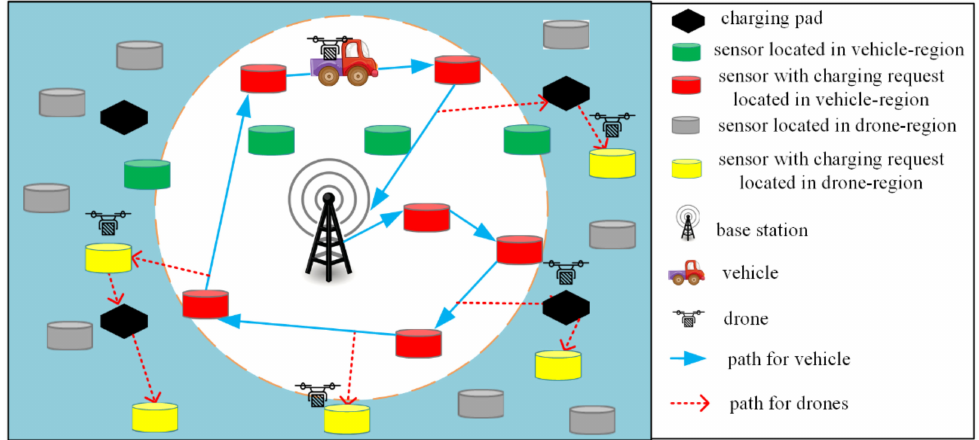
Figure 1. The proposed novel WRSN system that integrates one WCV, a set of WCV-carried drones, and